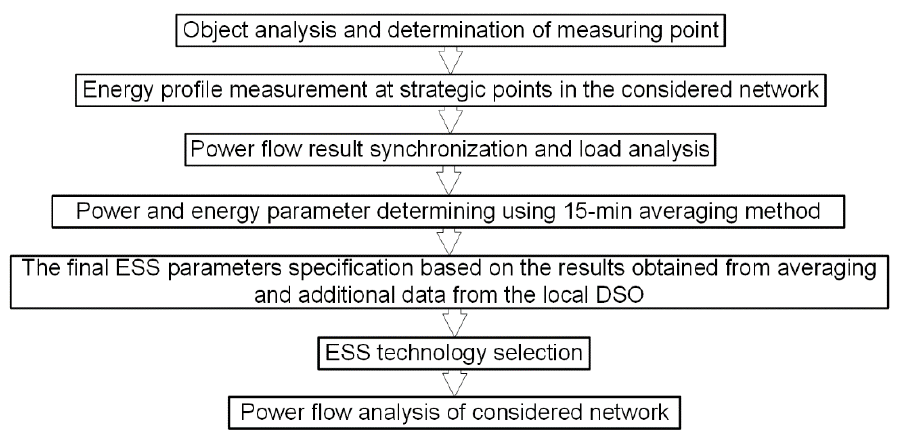
Figure 6. Simplified flow chart of the ESS selection.